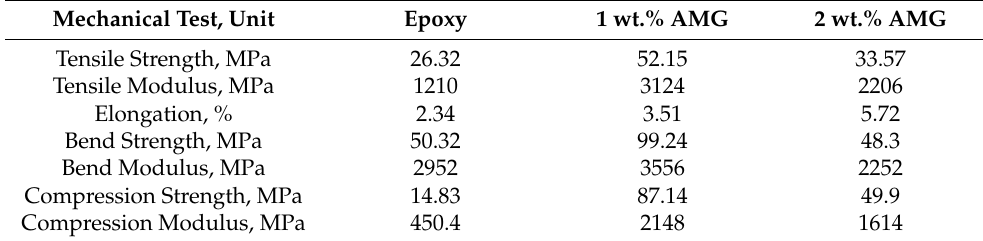
Table 1. The mechanical properties for epoxy-AMG nanocomposites.